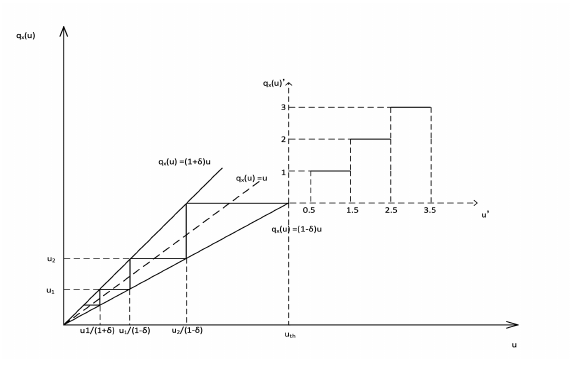
Figure 1. Novel adaptive dynamic